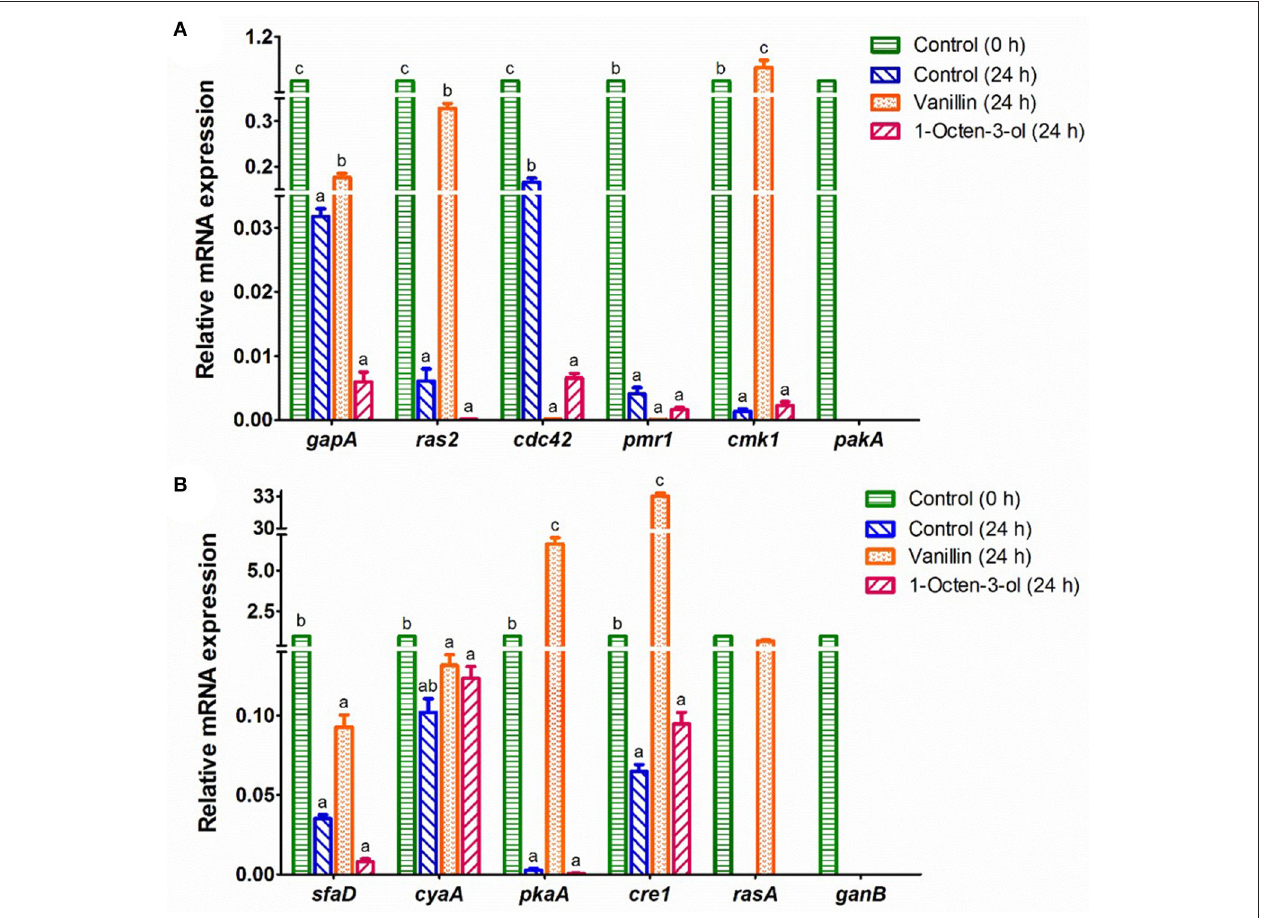
FIGURE 4 | RT-qPCR analysis of the mRNA expression of genes which might relate to the germination of A. camphorata arthroconidia. (A) gapA , ras2 , cdc42 , pmr1, cmk1, and pakA ; (B) sfaD , cyaA , pkaA , cre1 , rasA , and ganB . The 18S rRNA gene of A. camphorata was used as an internal reference, and non-germinated arthroconidia (0h) was used as control. Data were presented as mean ± SD . Inter-group statistical differences of the relative expression level of a specific gene were evaluated with Tukey’s multiple-range test. P < 0.05 were considered statistically significant. Columns marked with different letters in a treatment group possess values of significantly difference ( P <